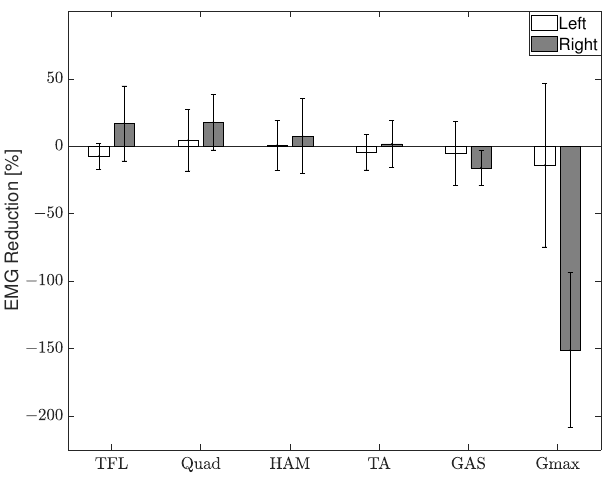
Figure 13. EMG reduction ratio of the measured muscle groups during stance for an individual with CP.